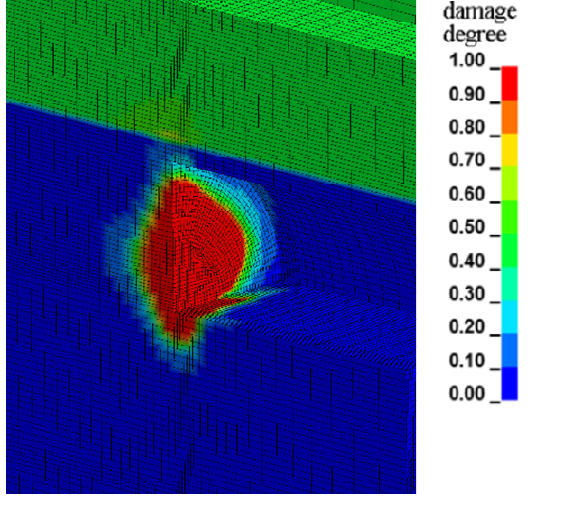
Figure 12. Blasting damage diagram of surrounding rock ( d = 3 m). ( a ) three ‐ dimensional blast ‐ ing damage diagram. ( b ) cross ‐ section blasting damage diagram.